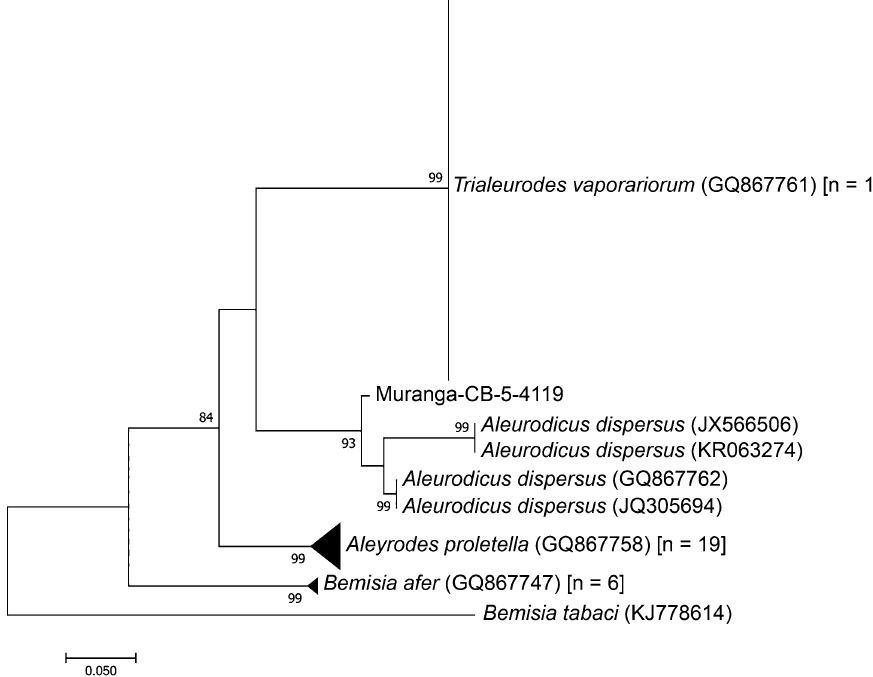
Figure 2. Maximum-likelihood tree based on a 650 bp alignment of 188 sequences of the 16S ribosomal RNA ( rrna) gene using the 4119/4118 markers from whitefly samples collected from Kenya and reference whitefly sequences available in GenBank (n = 5), with Aphis gossypii as an outgroup. The number of sequences obtained in this study are indicated in square brackets. Branchsupport was based on 1000 bootstrap replicates.